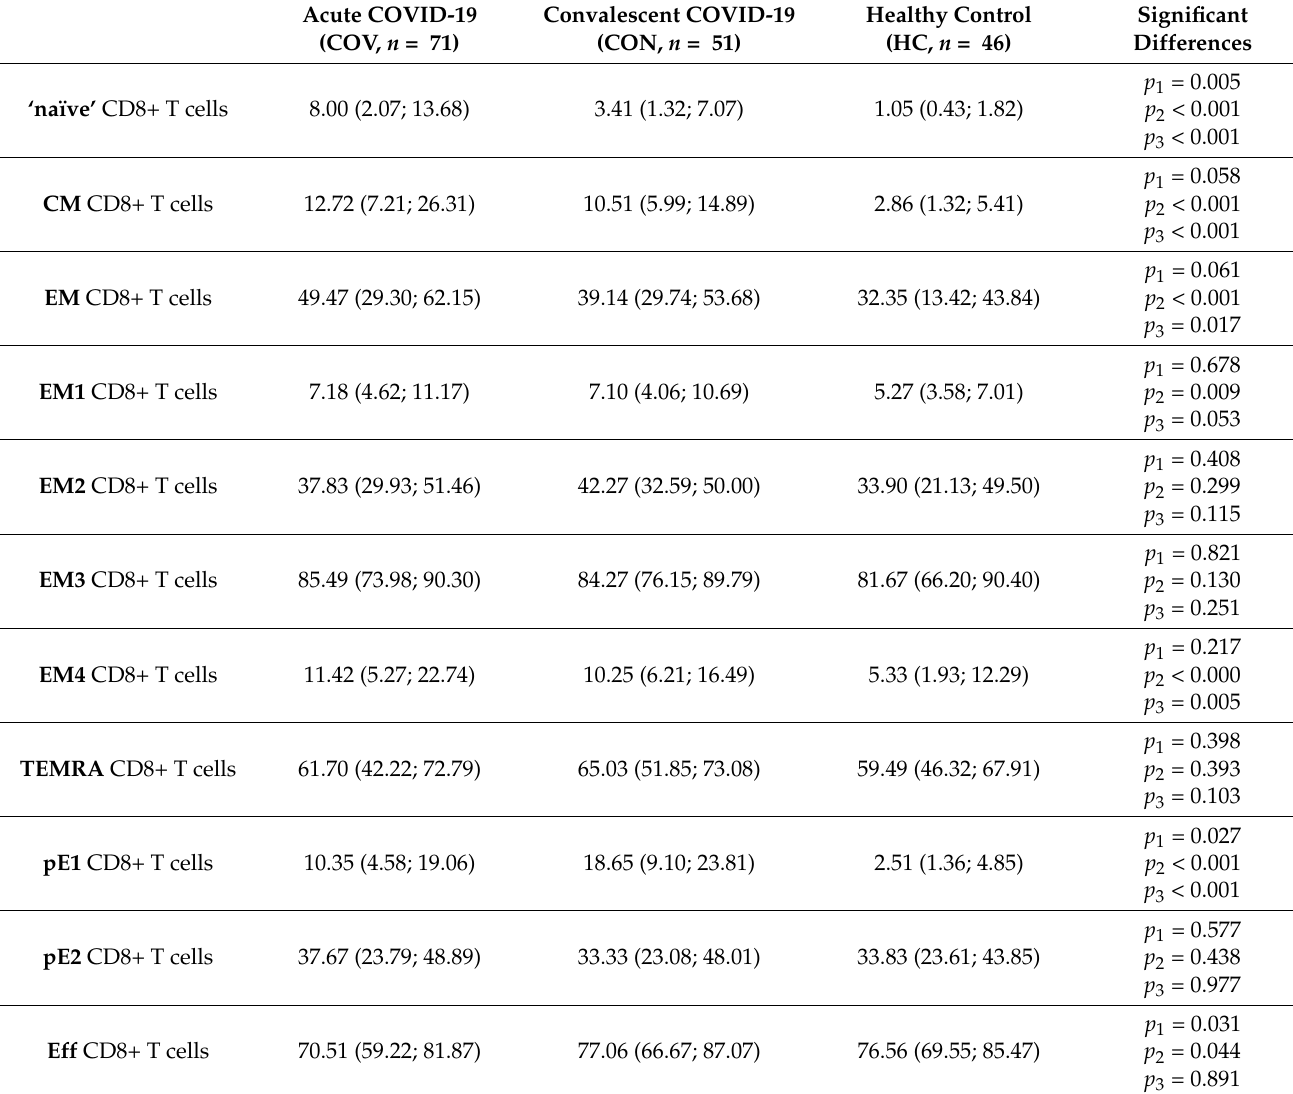
Table 1. CD57 expressed on diverse CD8+ T cell subsets in acute COVID-19 and convalescent COVID- 19 individuals. The quantitative data (% of CD57-expressing cells within CD8+ T cell subset) are presented as median and quartile ranges (Med (Q25; Q75). Acute COVID-19 Convalescent COVID-19 Healthy Control Significant (COV, n = 71) (CON, n = 51) (HC, n = 46)